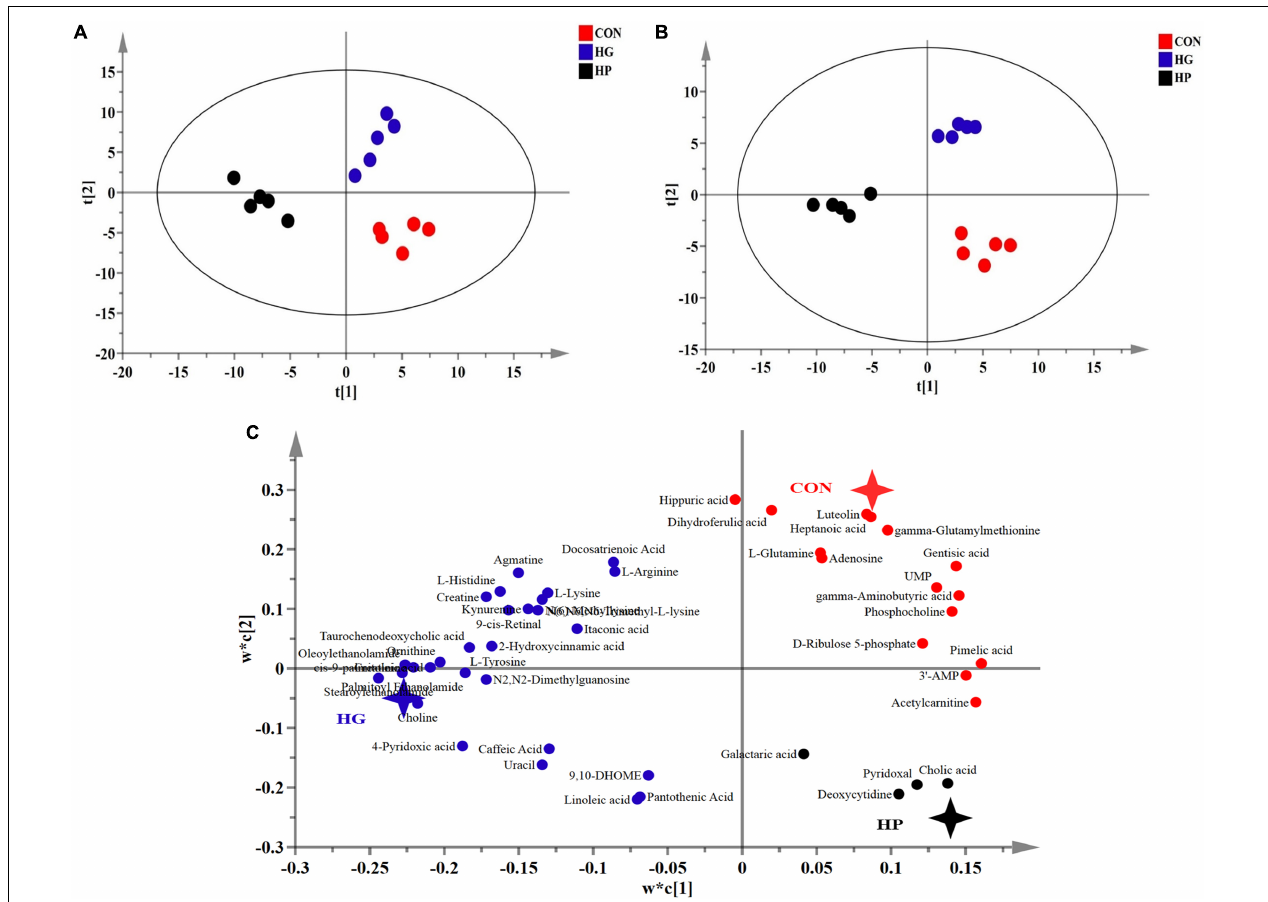
FIGURE 3 | Partial least squares discriminant (PLS-DA) ( A , score plots; C , loading plots) and orthogonal partial least squares discriminant (OPLS-DA; B ) analysis of the ileal mucosal metabolites from Hu sheep fed CON, HG, and HP